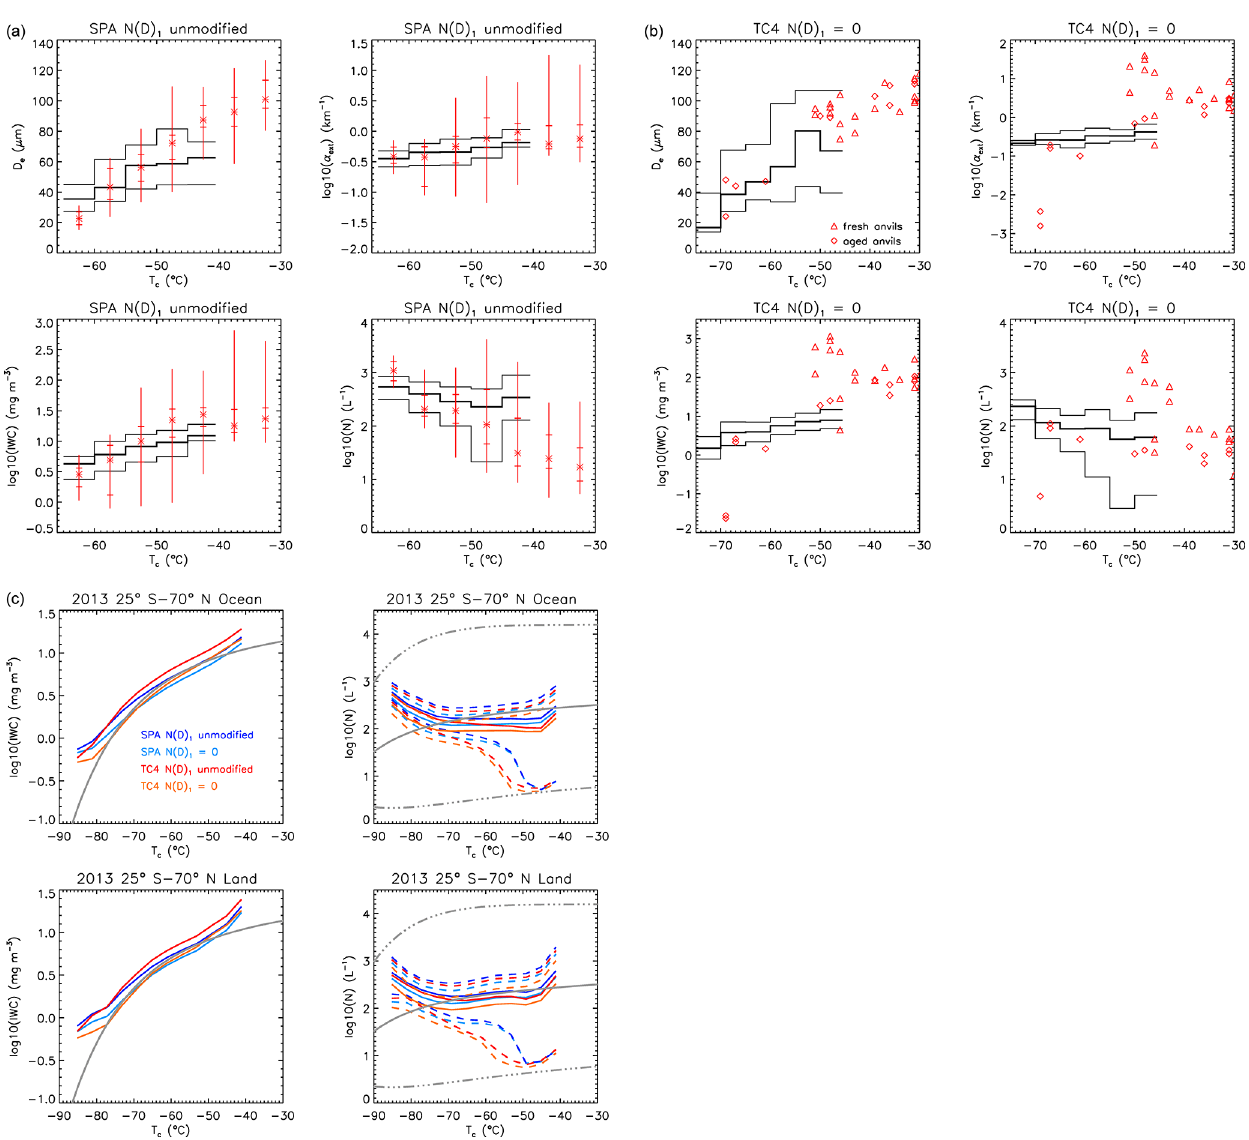
Figure 7. (a) SPARTICUS in situ measurements for synoptic cirrus (sampled January–April 2010) are in red, showing the temperature dependence of effective diameter D e (µm), extinction coefficient α ext (km − 1 ) , ice water content IWC (mgm − 3 ) and ice-particle number concentration N (L − 1 ) , and correspond to PSD measured within 5 ◦ C temperature intervals based on unmodified N(D) 1 . The vertical lines give the measurement range, the horizontal bars give the 25th and 75th percentile values, and the asterisks give the median value. Corresponding CALIPSO IIR retrieved properties using the SPARTICUS unmodified relationships are given by the thick black histograms, with thin black histograms giving the 25th and 75th percentile values. (b) Temperature dependence of effective diameter D e (µm), extinction coefficient α ext (km − 1 ) , ice water content IWC (mgm − 3 ) and ice-particle number concentration N (L − 1 ) during TC4, based on the N(D) 1 = 0 assumption. In situ TC4 measurements in red are for fresh (triangles) and aged (diamonds) anvils. Corresponding CALIPSO IIR retrieved median properties using the TC4 relationships are given by the thick black histograms, with thin black histograms giving the 25th and 75th percentile values. (c) Left: comparisons of the median CALIPSO IIR IWC (mgm − 3 ) for the four formulations (colored curves) with in situ measurements from Krämer et al. (2009) shown by the grey curve (which is the middle value). Right: comparisons of CALIPSO IIR N (L − 1 ) shown by the colored curves (solid curves are median values while dashed curves indicate the 25th and 75th percentile values) with the in situ N middle value (solid grey curve) from Krämer et al. (2009). The dot-dashed grey curves give the minimum and maximum in situ values. The navy and light blue curves correspond to the SPARTICUS formulations for the unmodified N(D) 1 assumption and the N(D) 1 = 0 assumption, respectively. The red and orange curves are using the TC4 formulations for the N(D) 1 unmodified and N(D) 1 = 0 assumptions, respectively. The CALIPSO IIR retrievals are from 2013 and are for the approximate latitude range (25 ◦ S to 70 ◦ N) of the in situ data, over oceans (top) and over land